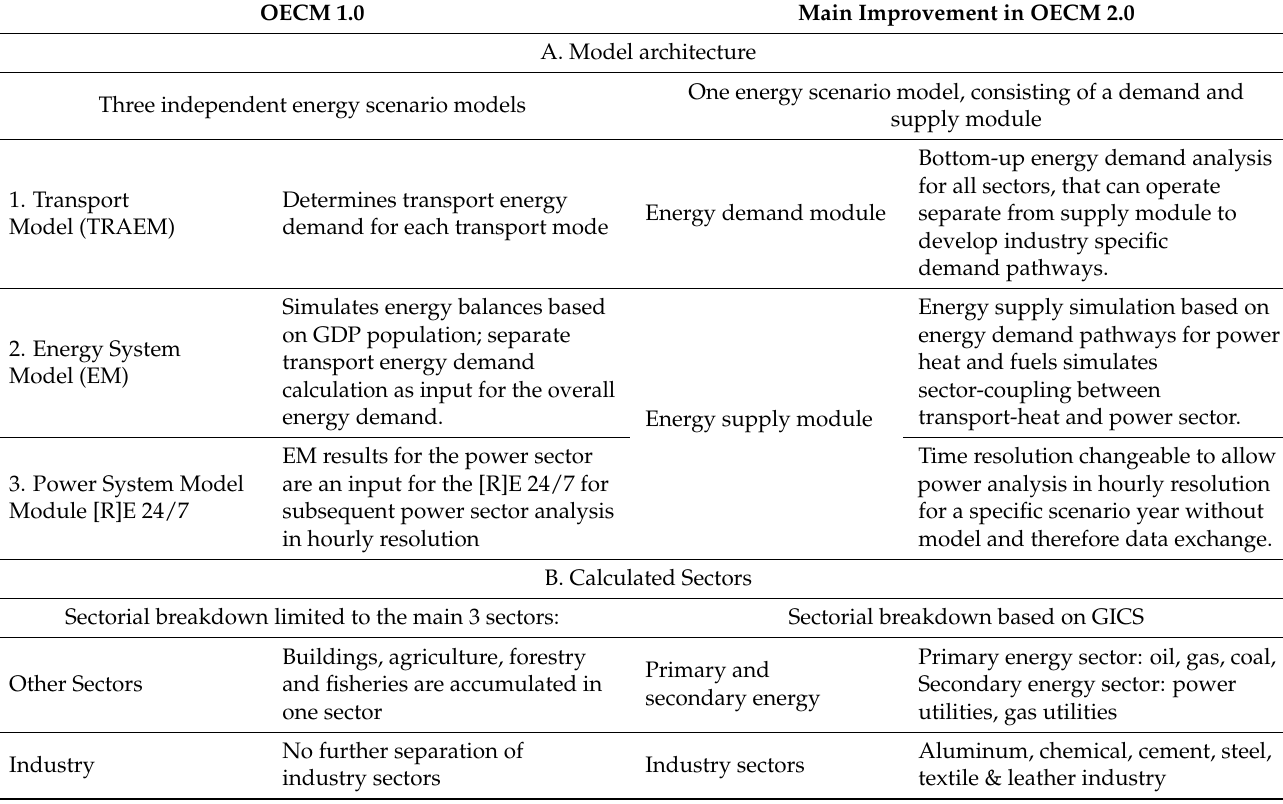
Table 1. Synopsis OECM 1.0 versus OECM